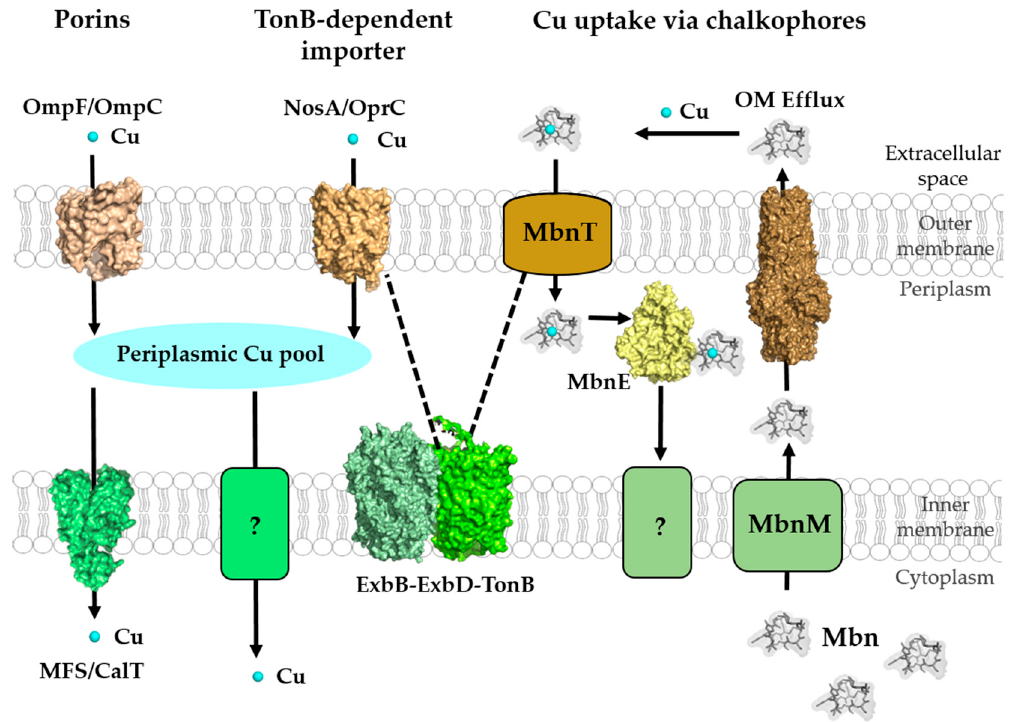
Figure 3. Cu-transport across the outer and inner membranes of bacteria. Bacteria use three established systems for Cu transport across the outer membranes: porins, TonB-dependent transport systems, such as NosA/OprC, and uptake via chalkophores, such as Methanobactin (Mbn), which represent Cu-specific metallophores. Periplasmic Cu is transported into the cytoplasm via the CcoA-like transporter (CalT), which belongs to the major facilitator superfamily. Additional Cu import systems (e.g., YcnJ-like proteins [93]) likely exist in bacteria, but have not been characterized [23]. Mbn is synthesized in the cytoplasm and transported via MbnM into the periplasm and by a so far unknown transporter into the extracellular space. Cu-loaded Mbn is imported back into the periplasm via the TonB-dependent transporter MbnT and bound by the periplasmic protein MbnE. How Cu-Mbn is transported back into the cytosol across the cytoplasmic membrane and how Cu is released from Mbn in the cytosol are unknown. Dashed lines indicate the interaction of the TonB-dependent transporter NosA/OprC and MbnT with the inner membrane ExbB–ExbD–TonB complex. Structures were retrieved from the protein database (PDB) with the following IDs: 2ZFG (OmpF for Porin), 3WDO (YajR for CalT/CcoA), 3j09 (CtaA), 4ZA1 (NosA), 5ZFP (ExbB/ExbD hexameric complex), 5ICQ (MbnE), 1EK9 (OM efflux), 2XJH (Mbn), and depicted using Pymol.